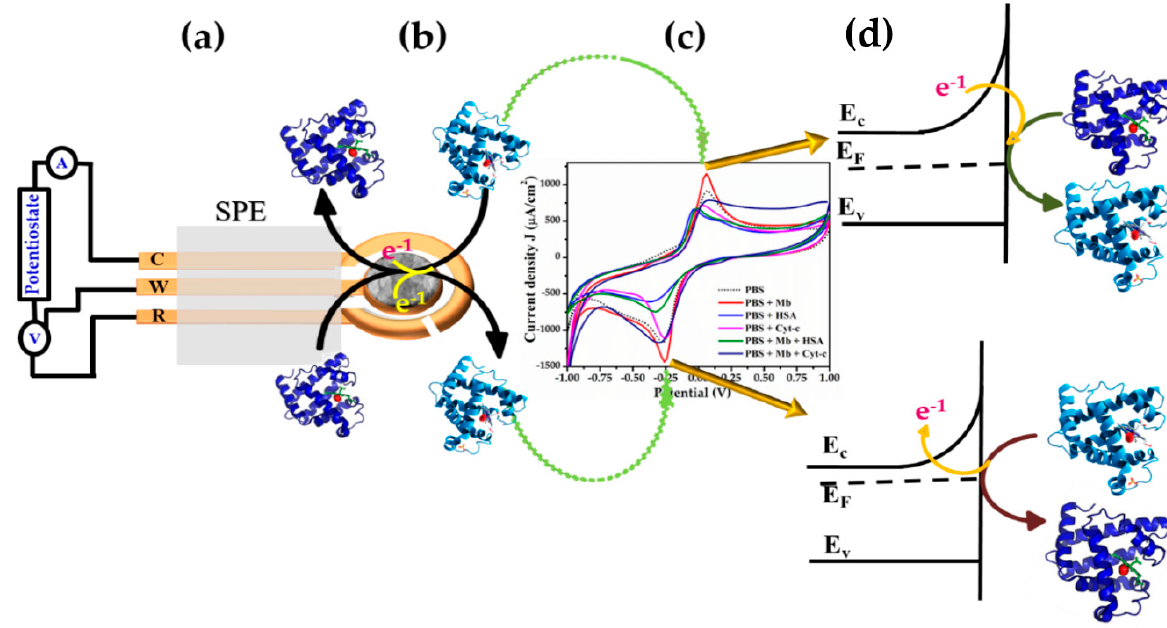
Figure 8. Schematic mechanism for the detection of Mb using pure and Cr-doped ZnO